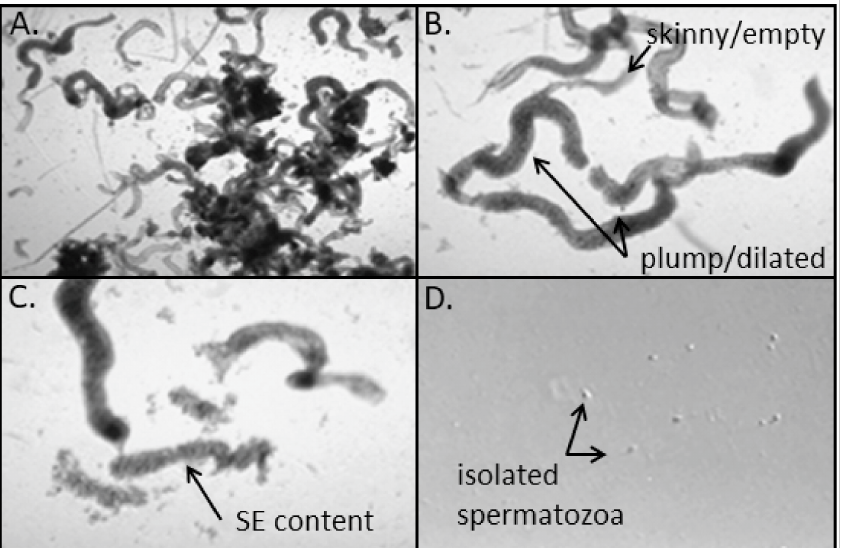
Figure 1. Composite micrographs of laboratory manual processing of testicular aspirate for sperma- tozoa isolation. ( A ) Minced seminiferous tubules (ST) in processing media. ( B ) Isolated truncated ST with indication of plump/dilated ST with presumed active spermatogenesis and skinny/empty ST (also transparent) with presumed absence of spermatogenesis. ( C ) Seminiferous tubules with one ST processed with tuberculin syringe and needles to squeeze out seminiferous epithelium (SE). ( D ) Fol- lowing pulled glass pipet dispersion of SE into single cells, the isolation of non-motile testicular spermatozoa. Magnifications: ( A )—100 × , ( B , C )—200 × , ( D )—400 ×